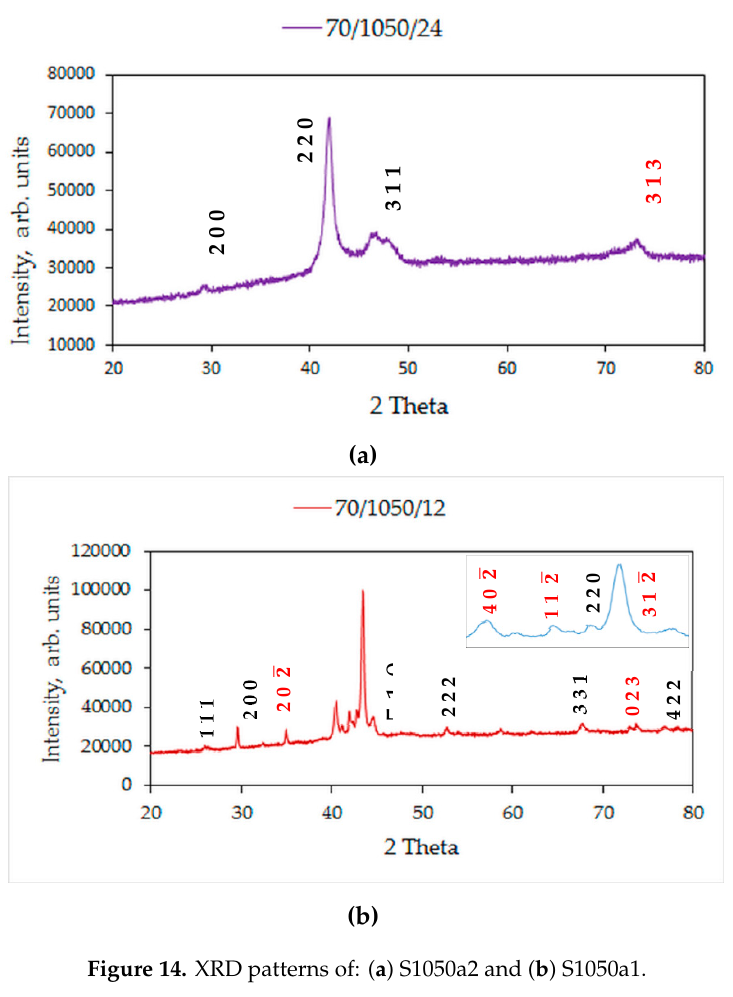
Figure 13. ( a ) BSE micrograph of S950b4 and ( b ) DSC curve of S950b4.